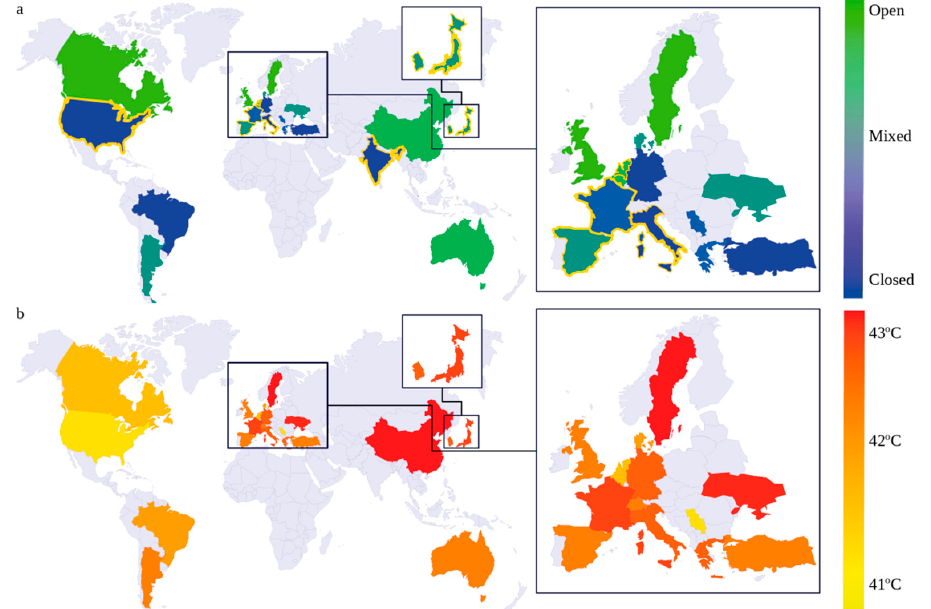
Figure 6. World maps showing the geographic variability of techniques ( a ) and median temperatures ( b ) used for HIPEC treatments. Countries where semi ‐ open, PCE, or laparoscopic techniques are used are lined with gold.